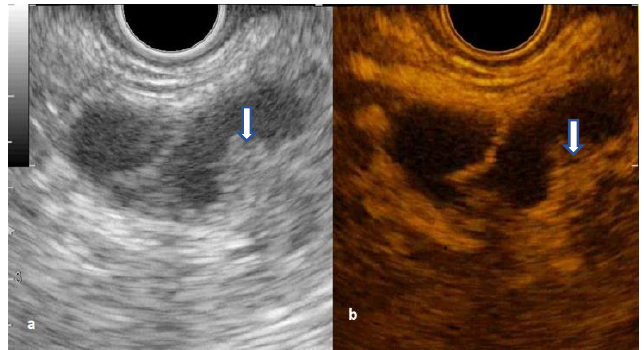
Figure 2. Secondary branch intrapapillary mucinous neoplasms with mural nodule (arrow): ( a ) B-mode EUS; ( b ) Contrast-enhanced EUS.